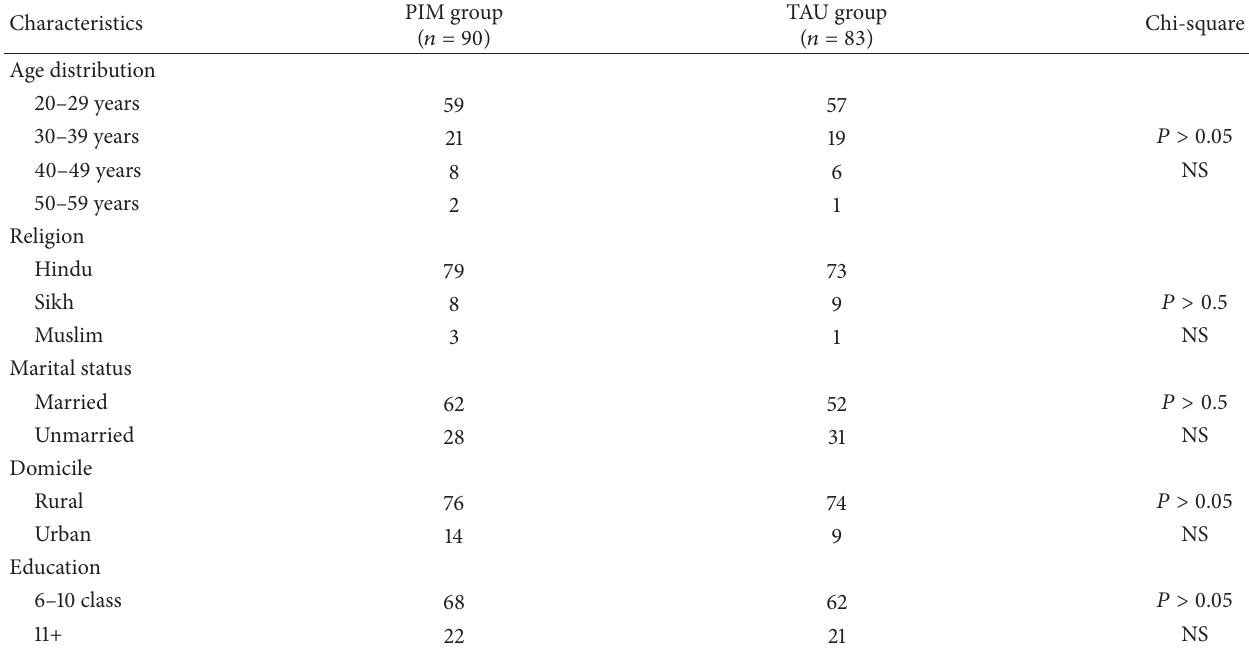
Table 1: Demographic characteristics of the amputees.